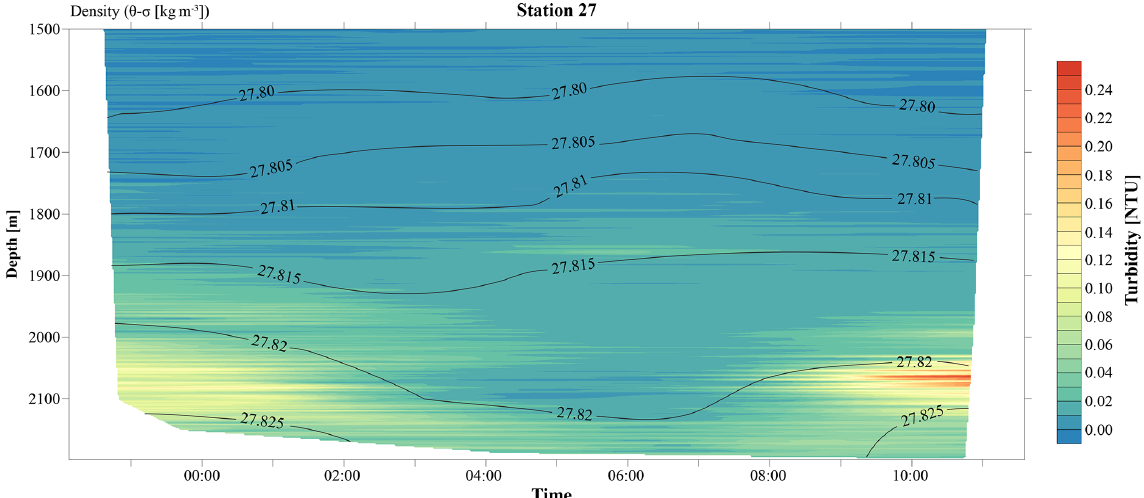
Figure 3. A 12h yo-yo CTD at station 27 showing the temporal evolution of the hydrothermal plume over a tidal